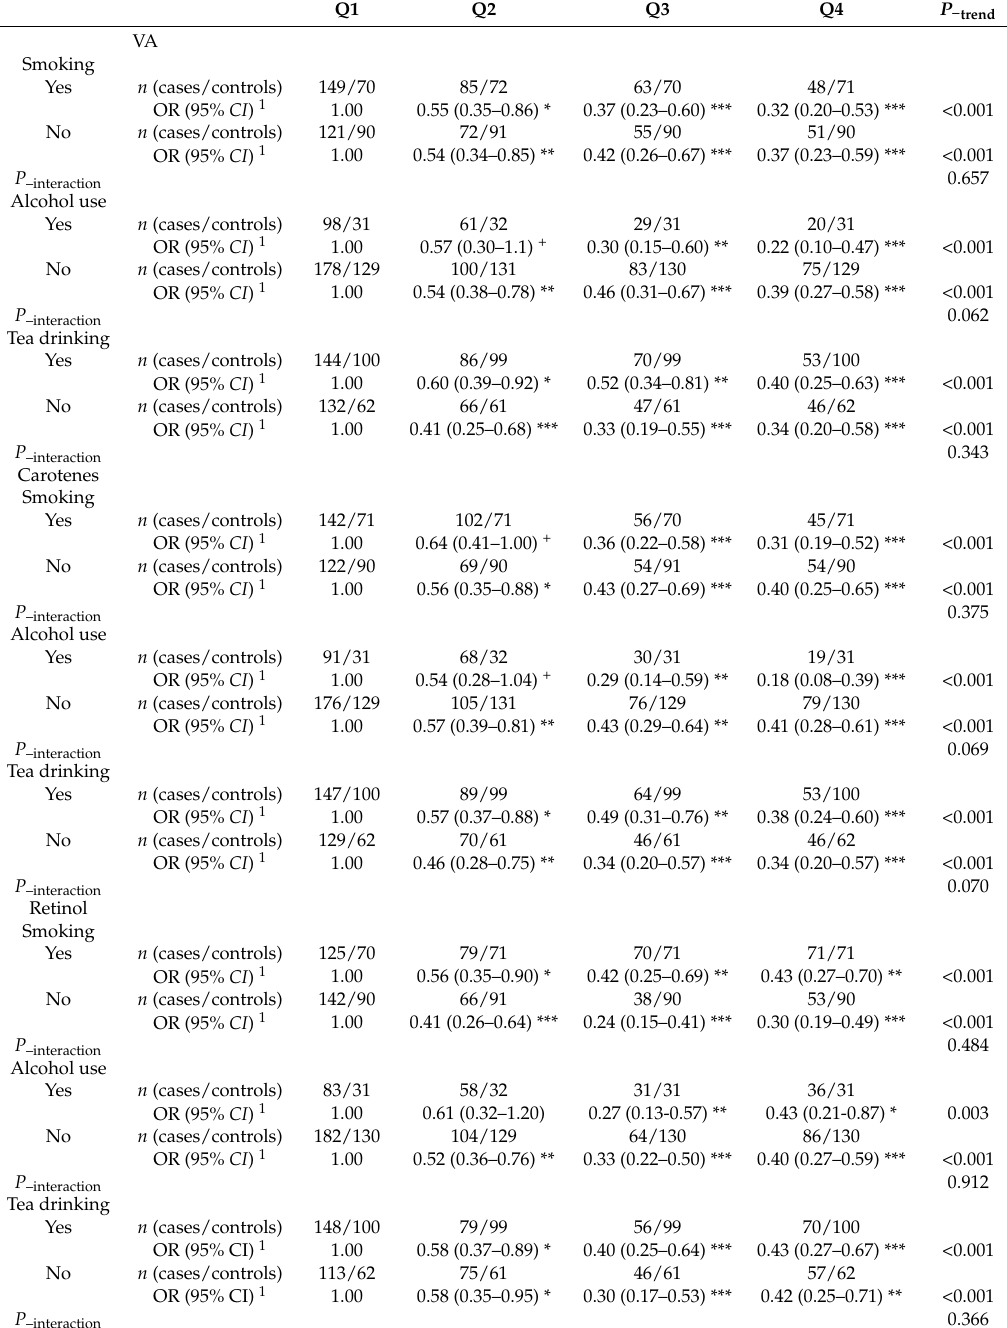
Table 4. Associations between quartiles of vitamin A, carotenes, and retinol intake by controls and PLC risk according to smoking and alcohol